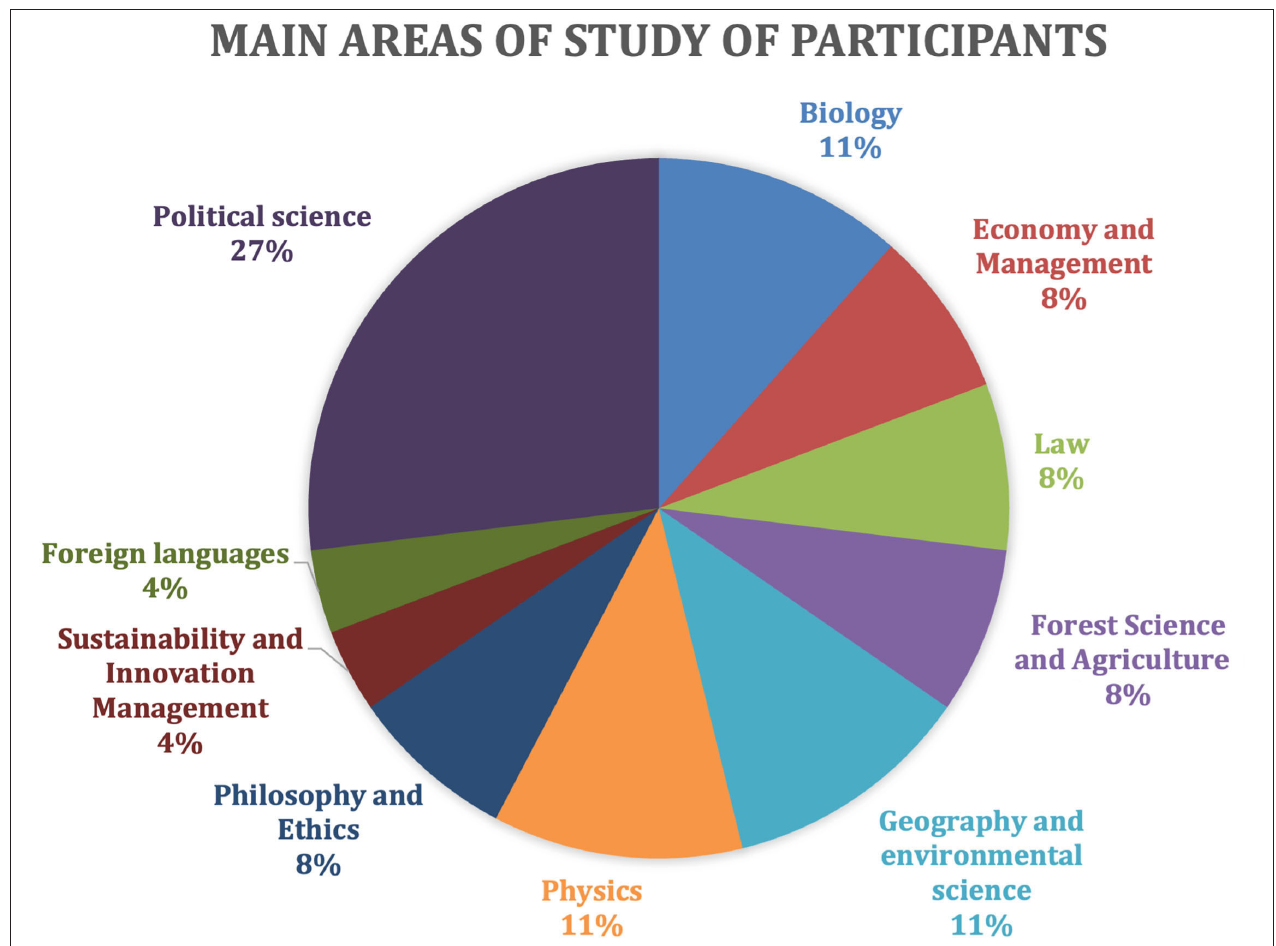
FIGURE 1 | Composition of students ( n =